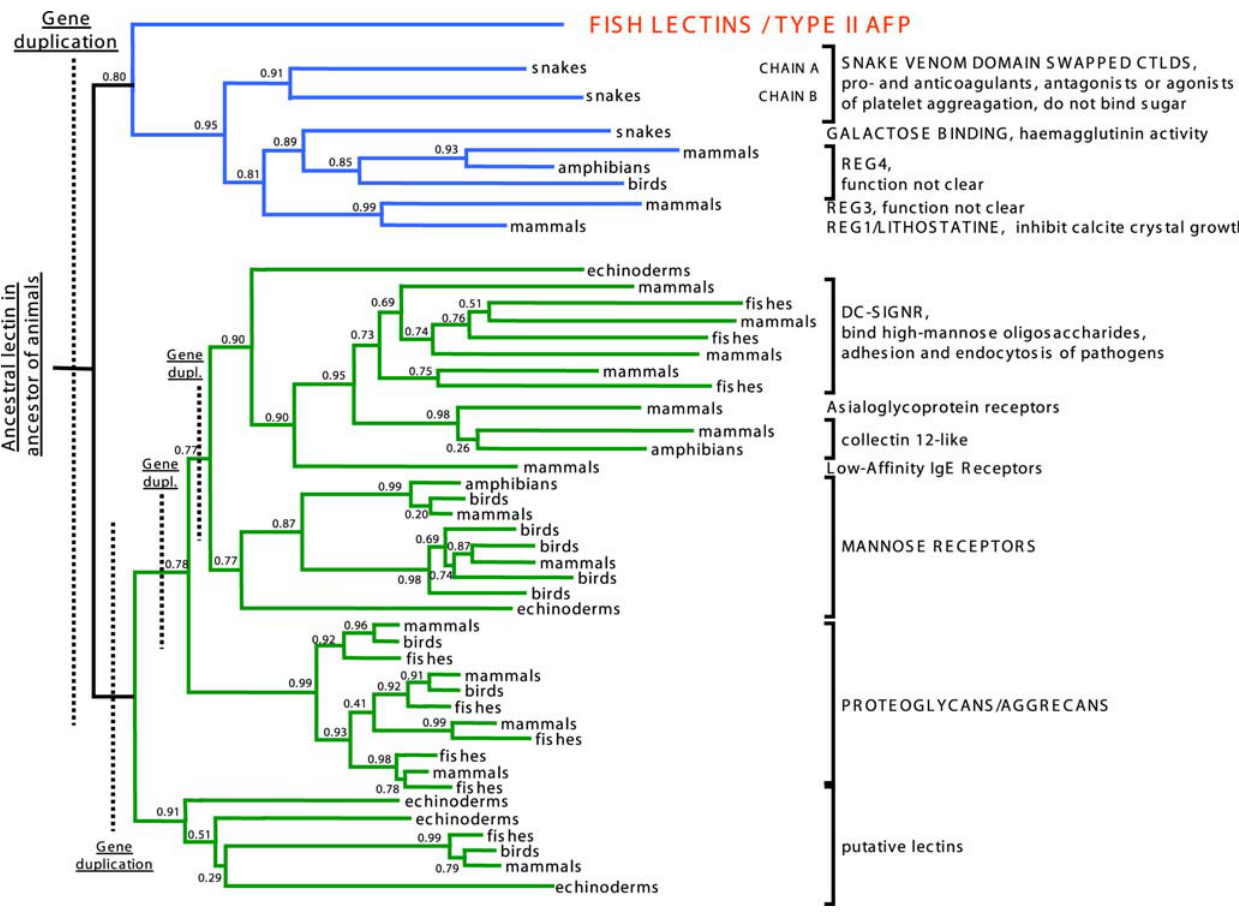
Figure 4. Maximum likelihood (ML) phylogenetic tree of type II AFPs, fish skin mucus lectins and other closely related lectins. Values at the nodes represent branch support (probability values) derived with parametric approximate likelihood ratio test for branches (aLRT). A clade postulated in this work to be monophyletic and containing type AFPs is shown in blue. Other clades are shown in green. The position of the root of the tree is hypothetical. Gene duplications responsible for a rise of major clades are indicated.